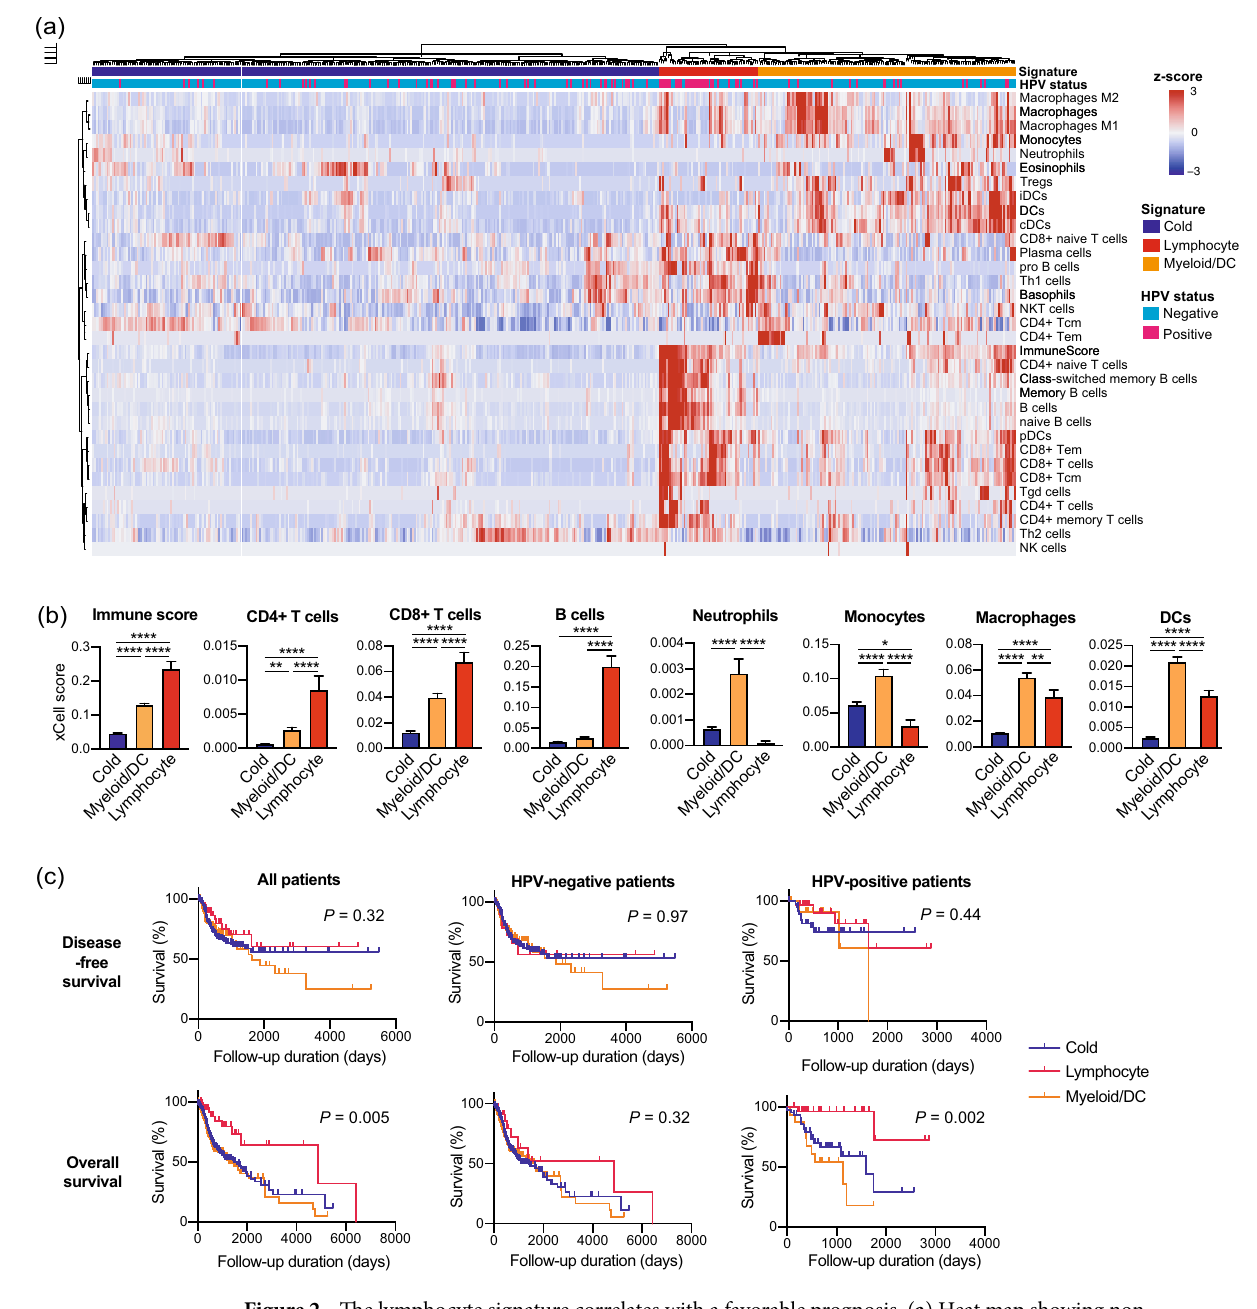
Figure 2. The lymphocyte signature correlates with a favorable prognosis. ( a ) Heat map showing non- supervised hierarchical clustering of 520 HNSCCs of TCGA cohort based on enrichment scores of 33 immune cell types. ( b ) Bar graphs of enrichment scores upregulated in the lymphocyte signature or myeloid/DC signature. ( c ) Kaplan–Meier survival curves based on the three immune signatures. Disease-free survival was evaluated in all patients (n = 429), HPV-negative patients (n = 348), and HPV-positive patients (n = 81). Overall survival was evaluated in all patients (n = 495), HPV-negative patients (n = 403), and HPV-positive patients (n = 92). HNSCC Head neck squamous cell carcinoma, HPV Human papillomavirus, DC Dendritic cells. *, P < 0.05; **, P < 0.01; ****, P <